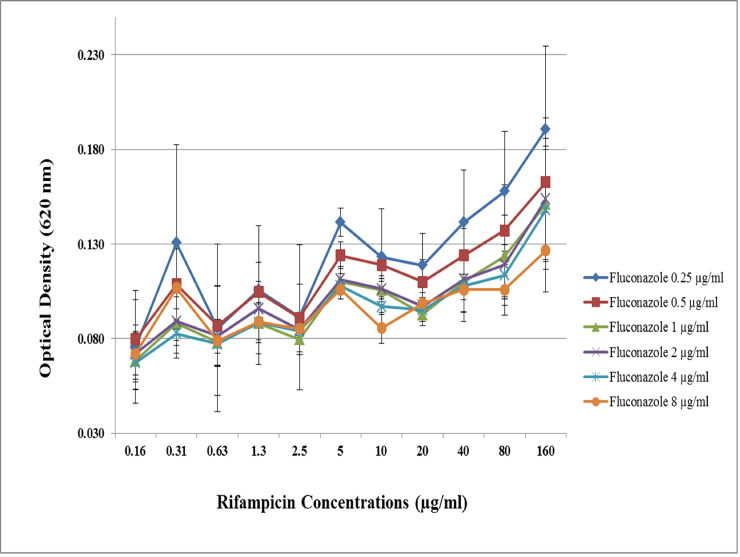
Effect of rifampicin to the fungicidal activity of fluconazole on the fluconazole sensitive C. albicans.The Optical Density (OD) of the checkerboard microdilution assay results was measured. The colors of line charts represent the different concentrations of fluconazole. The presence of rifampicin tended to increase the OD of the cultured C. albicans which correlates with the dose dependent increase in the population of viable yeast for all fluconazole concentrations. However, statistical analysis showed no significant difference (p>0.05). The results were shown with the standard error of triplicate individual experiments of 5 fluconazole sensitive C. albicans isolates.